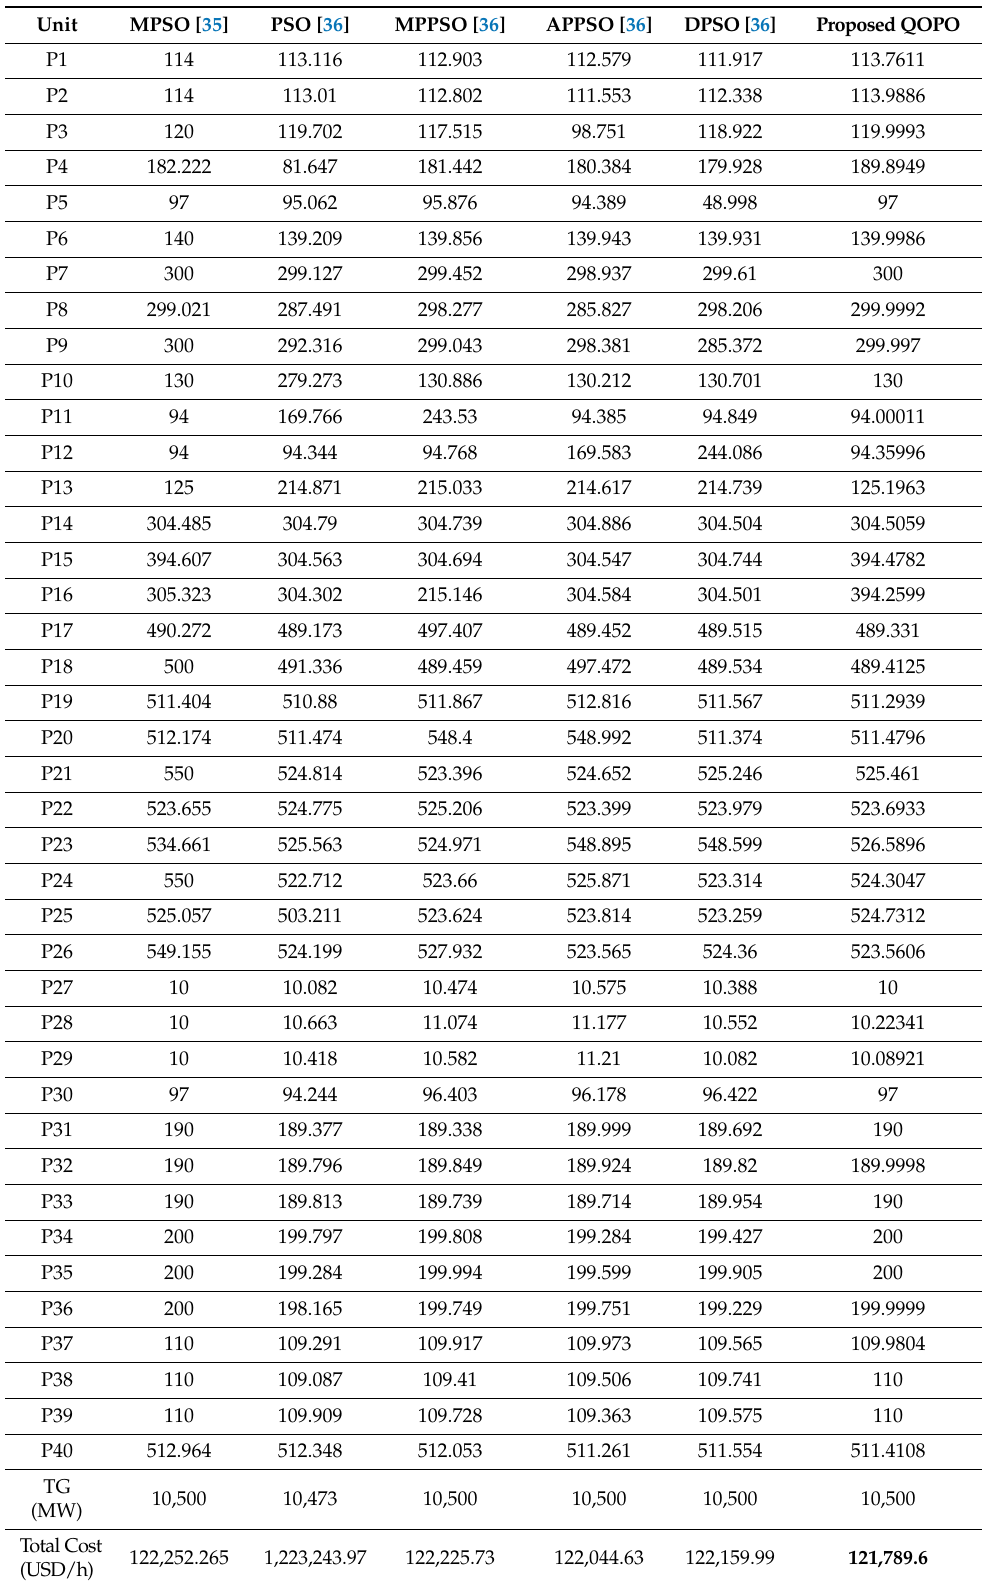
Table 7. Comparison of power distribution among 40 units for the load demand of 10,500